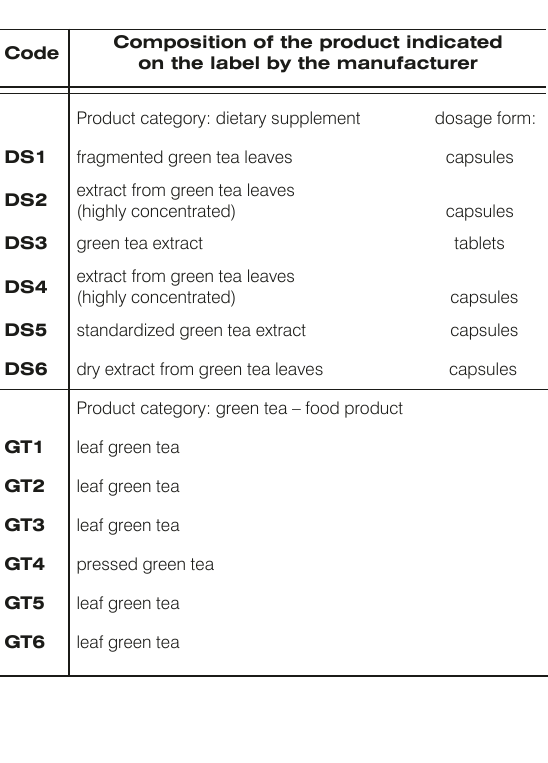
Table 1. The investigated commercial green teas and dietary supplements containing the extract from green tea leaves.